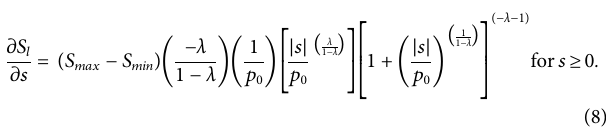
Frontiers in Earth Science |